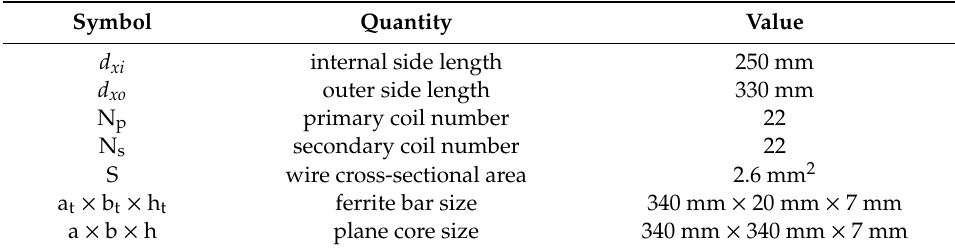
Figure 15. A 3D view of the square coil with ferrite core. Table 3. Parameters for square coil and ferrite